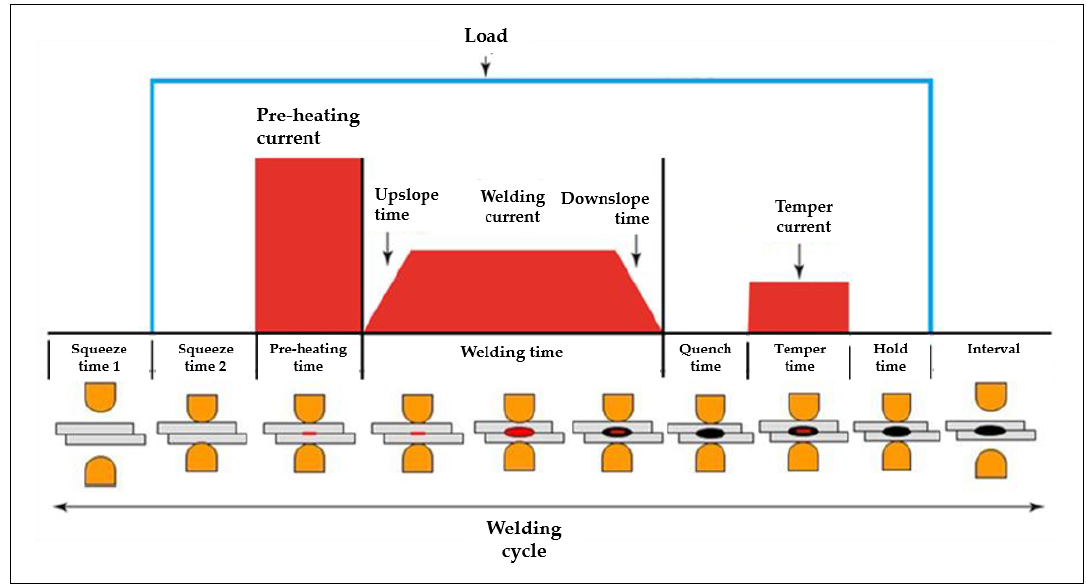
Figure 1. Resistance spot welding cycle scheme.